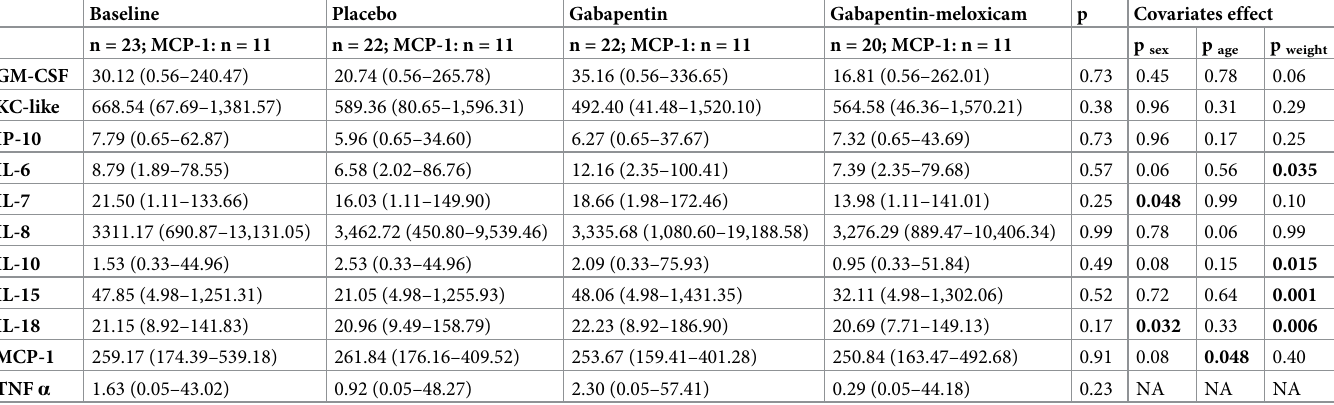
Table 5. Cytokine concentrations (median and range) in pg/mL measured in dogs with presumptive neuropathic pain (NeuP) before and after treatments of pla- cebo, gabapentin, gabapentin-meloxicam using the Milliplex Canine Cytokine Panel.